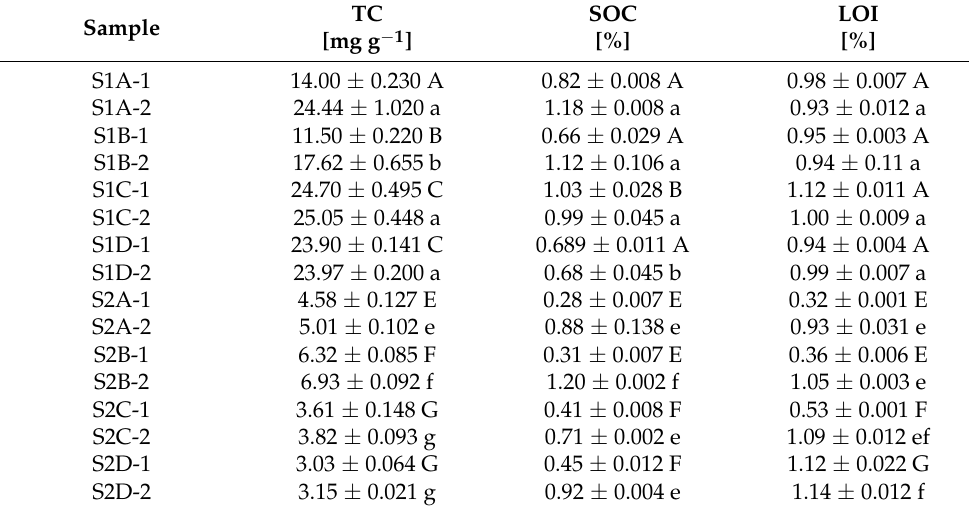
Table 5. Total carbon, soil organic carbon, and loss of ignition in the studied soils. S1: soil from the limestone open-cast mining remediated with embankment; S2: soil from the lignite open-cast mining remediated with sewage sludge; subsequent letters A–D mean different remediated areas located at the same mine site; subsequent numbers mean different sampling periods; 1: spring 2021, 2: spring 2022. Mean values ± SD, n = 3. Different letters in the columns indicate significant differences between tested treatments ( p < 0.05) according to Tukey’s test. Small and capital letters indicate separate analyses for both sampling soils (capital letters indicate the tests between soils collected in 2021, and small letters in